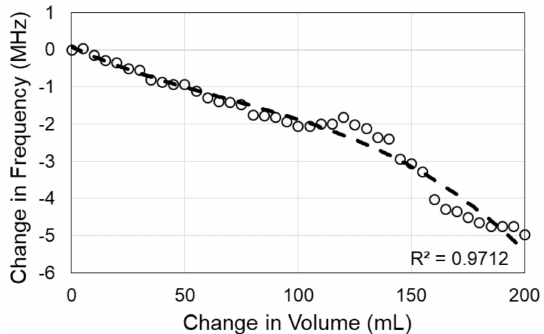
Figure 5. ( A ) Sensor signal response due to volume change. Each line color represents the sensor signal response at a different volume level; ( B ) Correlation between principal resonance frequency shift and volume change.